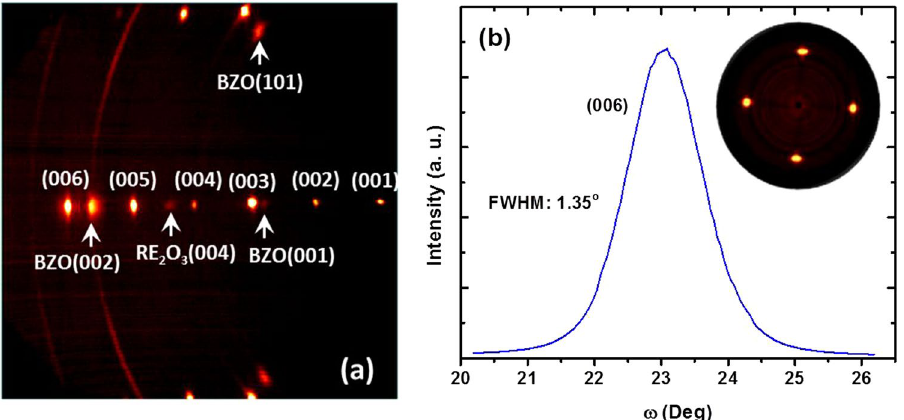
Figure 1. ( a ) GADDS 2D x-ray diffraction patterns from the ∼ 3.2 μ m thick, 20% Zr-added REBCO film at χ = 90° to highlight the high quality crystallinity. ( b ) ω -scan to emphasize the out-of-plane texture. The inset of ( b ) is the pole figure of REBCO (103) peak. The sharp, four-fold symmetric peaks indicate a strong in-plane texture of REBCO